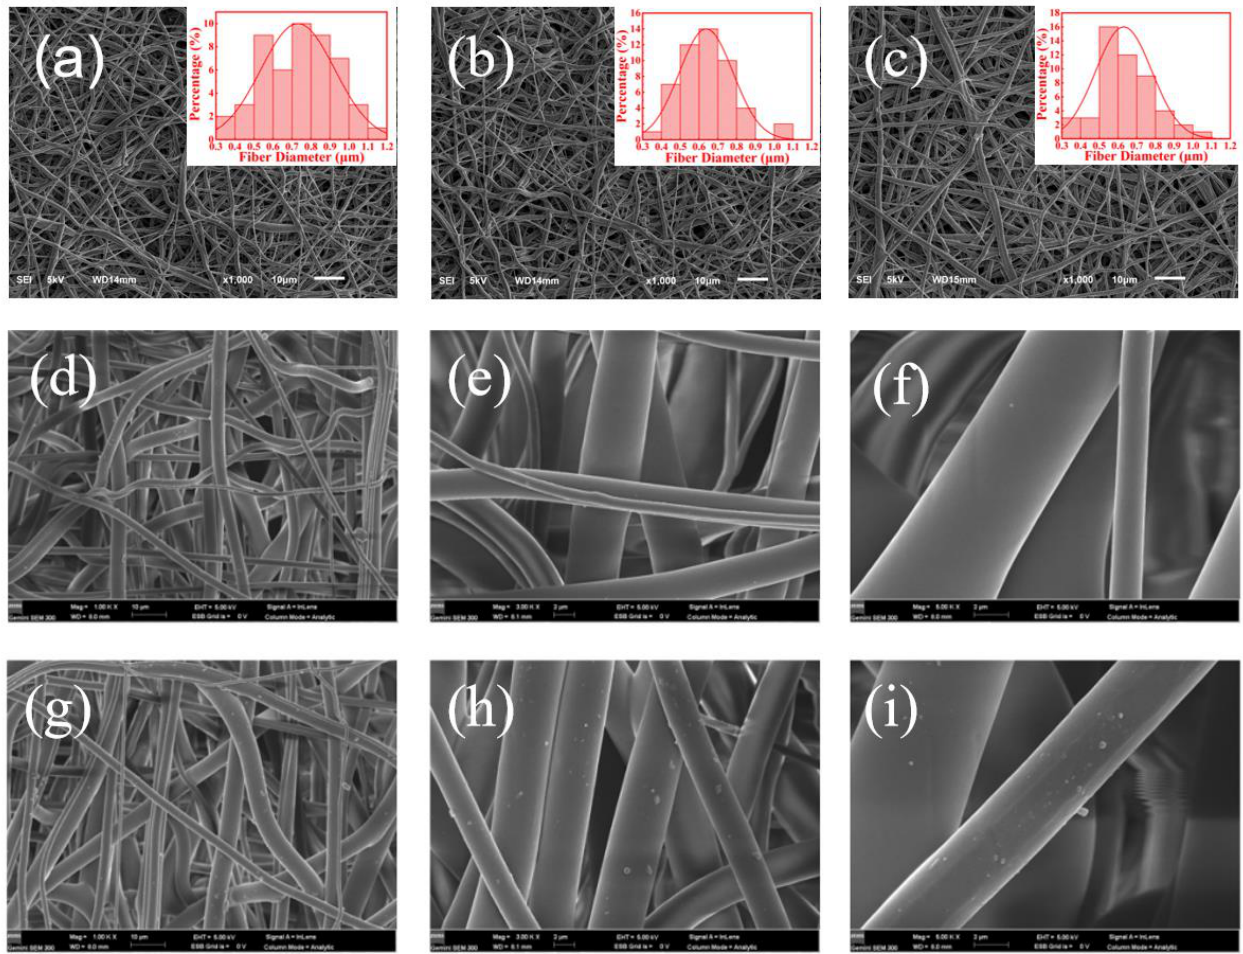
Figure 2. ( a – c ) SEM images of AgNP-embedded TPU nanofiber membrane with AgNP contents of 50, 100, and 300 mg·kg −1 . SEM images of ( d – f ) pure TPU nanofiber membrane and ( g – i ) AgNP-embedded TPU nanofiber membrane with AgNP contents of 100 mg·kg −1 .